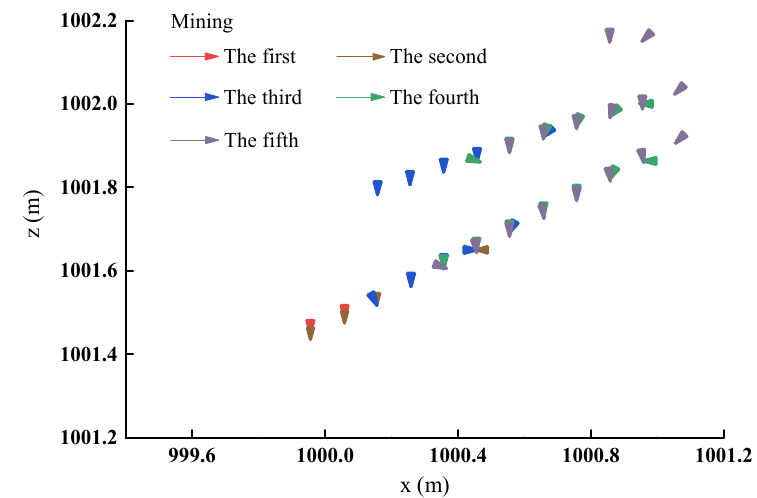
Figure 6. Displacement vector of mining in each sublevel.